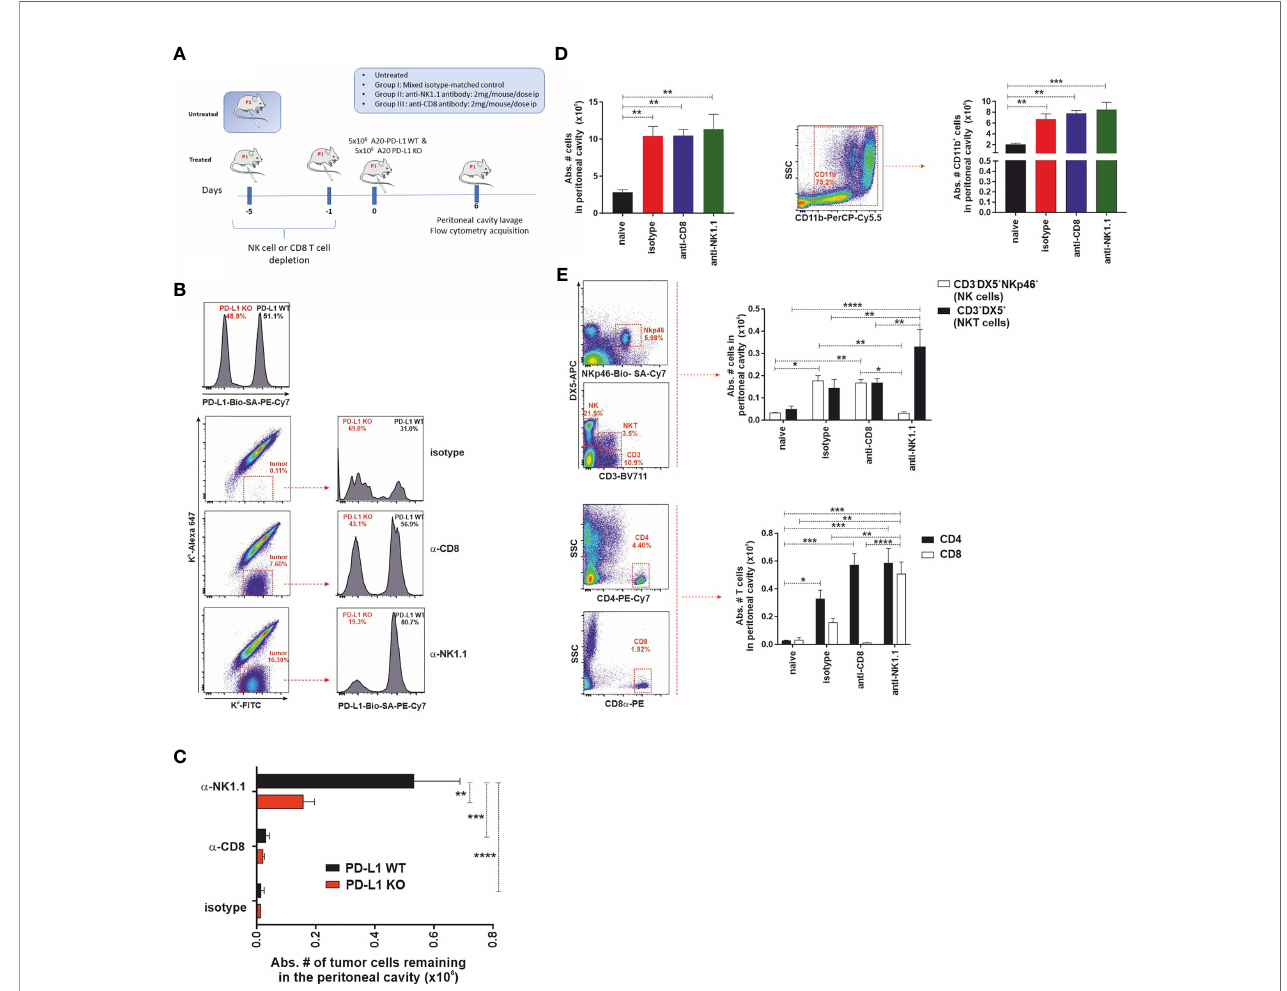
FIGURE 5 | The expression of PD-L1 in A20 tumor cells confers protection against CD8 T-cell-mediated antitumor response but does not affect the NK cell- mediated component of hybrid resistance. (A) Experimental design to assess the contribution of host CD8 T cells and NK cells to the phenomenon of hybrid resistance in F1 mice receiving A20 PD-L1 WT and PD-L1-de fi cient leukemia cells into the peritoneal cavity. F1 recipient mice were treated with isotype control or depleting antibodies against CD8 T cells or NK cells at days − 5 and − 1 prior to tumor implantation at day 0. An equal number of A20 PD-L1 WT and A20 PD- L1 KO tumor cells were intraperitoneally injected and mice were euthanized on day 6 after tumor implantation. Then, the cellular composition of the peritoneal lavage was analyzed by fl ow cytometry distinguishing tumor cells (positive for MHC class I, K d ) from non-tumor cells (host immune cells double-positive for MHC class I K b and K d ). (B) Top panel: A representative histogram example showing the ratio of the A20 PD-L1 WT/A20 PD-L1 KO tumor cell mix (ratio 1:1) after staining with anti-PD-L1 antibody and prior to the injection into the peritoneal cavity of F1 recipient mice. Bottom panel: A representative dot plot showing host cells (K b+ /K d+ ) and tumor cells (K b − /K d+ ) of each experimental group (isotype-matched control and anti-CD8 a - or anti-NK1.1-depleted F1 recipients are depicted). The percentage of A20 PD-L1 WT and A20 PD-L1 KO tumor cells remaining in the peritoneal cavity 6 days after tumor injection was calculated by excluding residual red cells and gating on K b − /K d+ tumor cells and the histogram plot shows PD-L1 staining to differentiate A20 PD-L1 WT from PD-L1 KO leukemia cells. (C) The absolute number of A20 PD-L1 WT and KO tumor cells remaining in the peritoneal cavity 6 days after their injection is depicted for isotype matched control and anti-CD8 a or anti-NK1.1-depleted F1 recipients. (D) Tumor inoculation into the peritoneum attracts immune cells toward this location. Upper panel: The bar graph shows the absolute number of immune cells in the peritoneal cavity of tumor-bearing F1 mice compared to the normal number of immune cells in the peritoneal cavity of naive F1 mice. Representative dot plot depicting the gating strategy and the subpopulation of CD11b cells in the peritoneal cavity. The bar chart represents the absolute number of host CD11b myeloid cells recruited into the peritoneal cavity in response to tumor implantation compared with that of naive F1 mice. Middle panel: Representative dot plot depicting the gating strategy for NK cells and NKT cells in the peritoneal cavity. The bar chart represents the absolute number of NK cells (CD3 − /DX5 + /NKp46 + cells) and NKT cells (CD3 + /DX5 + ) recruited into the peritoneal cavity of F1 mice in response to the inoculation of an equal number of A20 PD-L1 WT and KO tumor cells, 6 days after tumor injection. Lower panel: Representative dot plot depicting the gating strategy for CD4 T cells and CD8 T cells in the peritoneal cavity. The bar chart illustrates the absolute number of CD4 T cells and CD8 T cells in the peritoneal cavity of F1 mice co-injected with an equal number of A20 PD-L1 WT and KO tumor cells, 6 days after tumor injection. The plotted data represent the mean ± SEM from 5 to 8 mice per group. p -values were considered statistically signi fi cant according to the following criteria: * p < 0.05; ** p < 0.005; *** p < 0.0005; ****, p < 0.00005. Student ’ s t -test and two-way ANOVA were used to assess the statistical signi fi cance of the means. WT, wild type; KO,